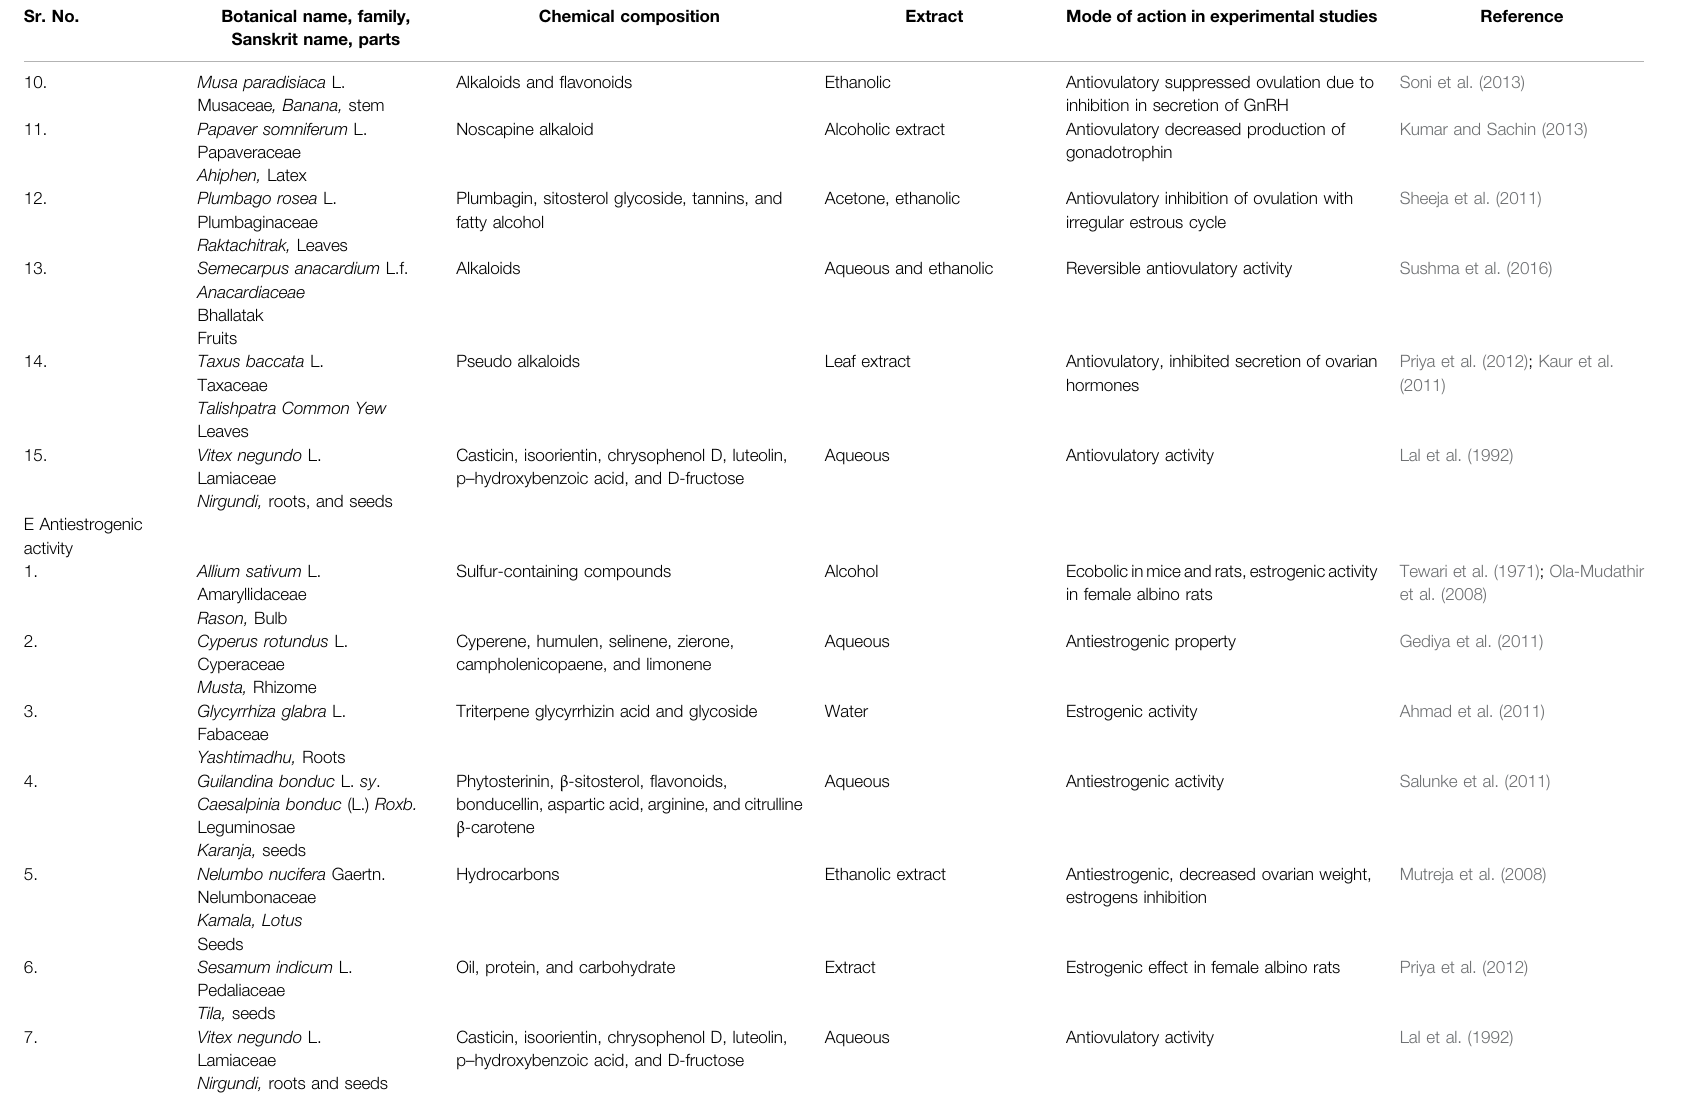
TABLE 2 | ( Continued ) Medicinal plants and their phyotoconstituents validated for various female/male contraceptive activities. Different contraceptive activities studied on medicinal plants could be categorized as follows. Female contraceptive activities: (2A) anti-implantation activity, (2B) aborti fi cation, (2C) antifertility, (2D) antiovulatory, and (2E) antiestrogenic activity. Male contraceptive activities: (2F) antispermatogenic, (2G) spermicidal, and (2H) antiandrogenic